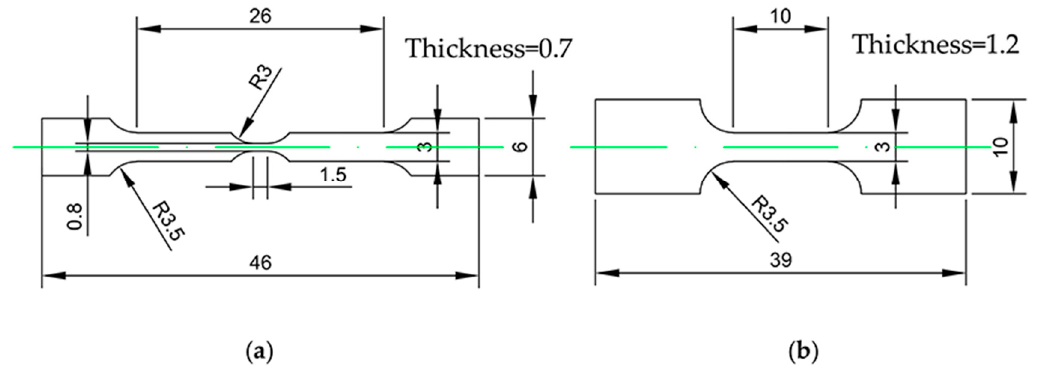
Figure 1. Geometry of the tensile test specimens. ( a ) In situ test specimen, ( b ) ex situ test specimen. Units, mm.